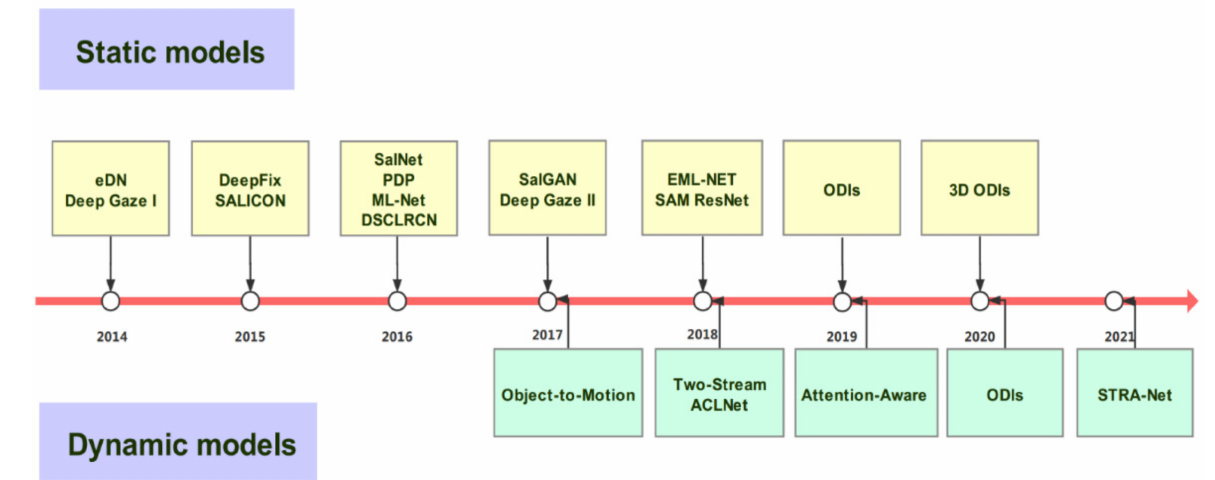
Figure 3. Development process of deep saliency prediction